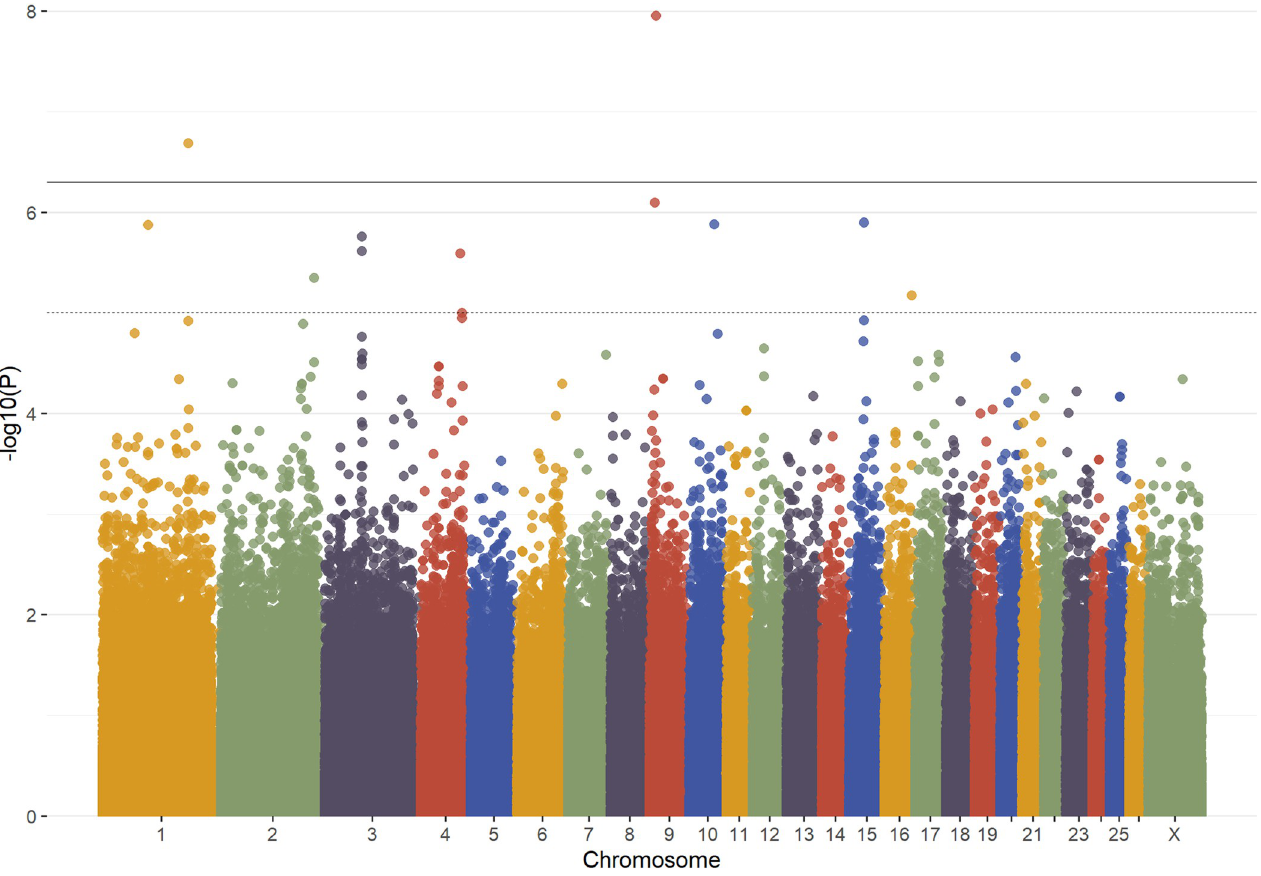
Fig 1. Manhattan plot of absolute monocyte count GWAS. The Manhattan plot displays all nominal p values from the GWAS for absolute monocyte count by chromosomal position. Representative data from the additive genetic analysis is shown. The dotted and solid lines respectively denote p values of 1x10 -5 (genome-wide suggestive) and 5x10 -7 (genome-wide